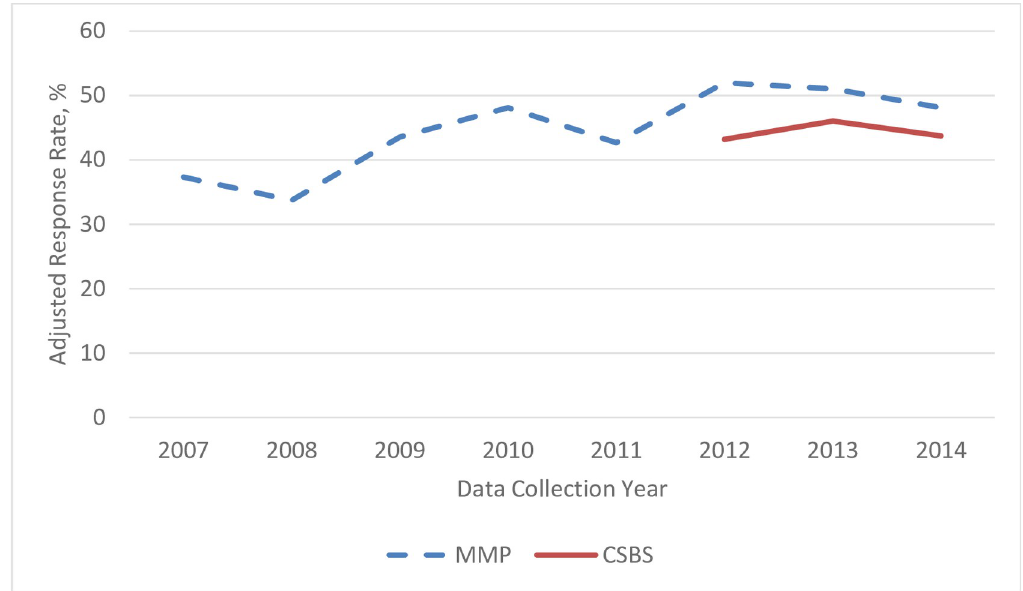
Fig 3. Comparison of adjusted interview response rates by data collection year in the facility-based Medical Monitoring Project (MMP) and the Case-Surveillance-Based Sampling (CSBS) demonstration project.